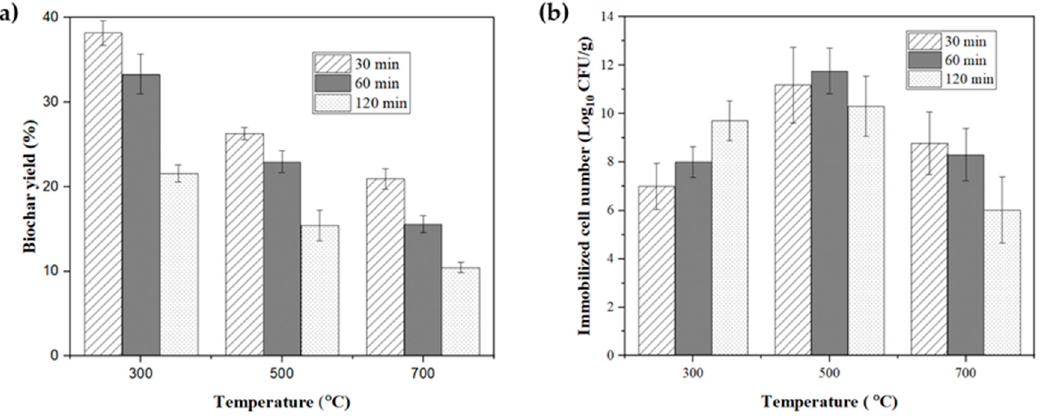
Figure 1. SDB produced at various temperatures (300, 500, and 700 °C) and time (30, 60, 120 min); ( a ) biochar yield (%); ( b ) number of cells immobilized on SDB. ( a ) biochar yield (%); ( b ) number of cells immobilized on